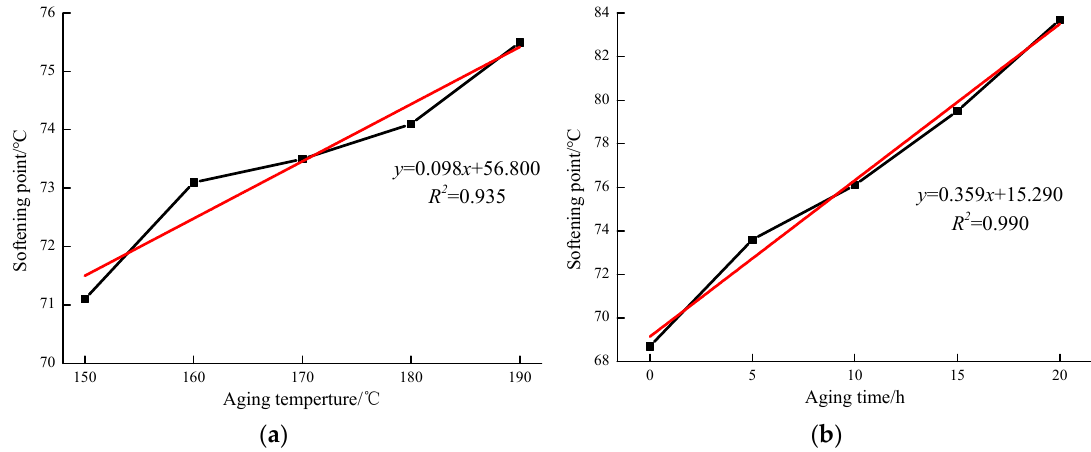
Figure 4. Softening point values of MACRMA at different aging conditions: ( a ) aging temperature and ( b ) aging time.